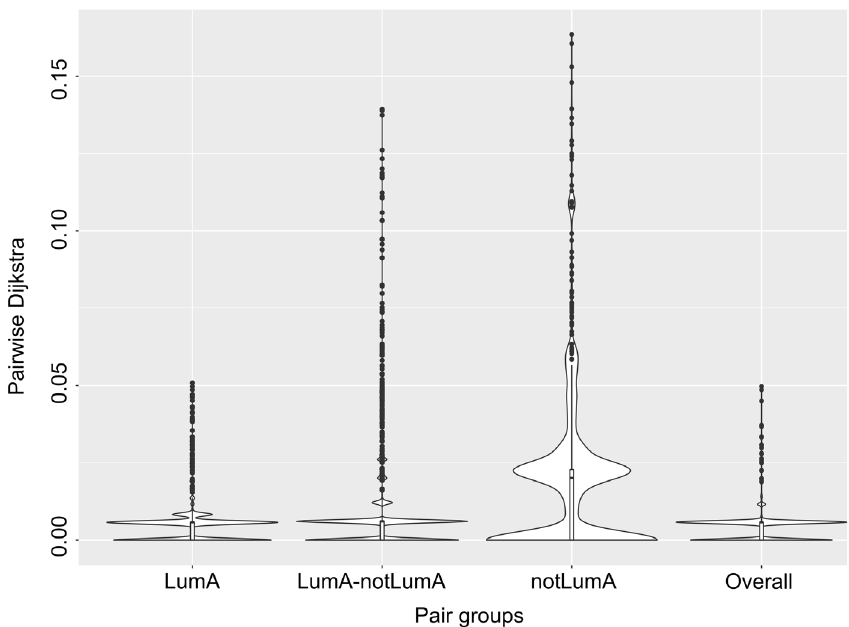
Figure 6. Shortest pairwise patient distances within and among patient classes in the integrated network for breast tumour classification. This visualization and statistic are useful to ascertain whether or not patients of the same label are more similar in the integrated network; having within-class distance be significantly smaller than across- class distance is indicative of good class separation. This graph is generated using the plotIntegratedPatientNetwork() function. From left to right, it shows pairwise patient shortest distances: within patients of class “LumA”; between the two class labels; within patients of the residual class “nonLumA”; and between all patients in the